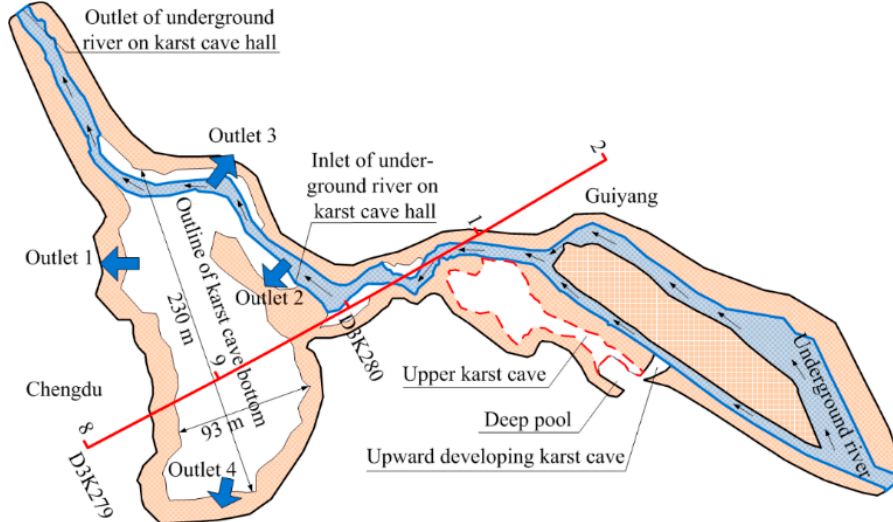
Figure 3. Hydrological profile of karst cave hall.